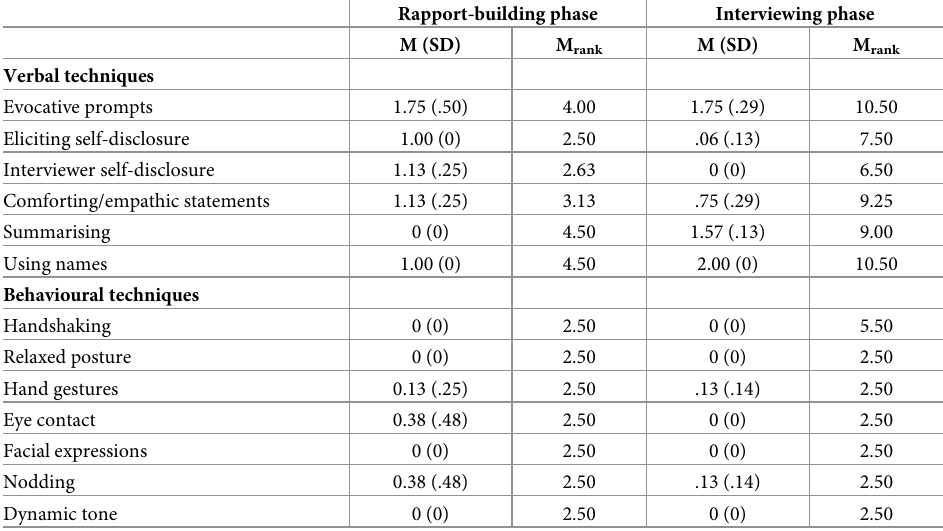
Table 2. Mean coding and Kruskal-Wallis rankings (standard deviations) for techniques in the verbal rapport condition as a function of the rapport-building and interviewing phase. Rapport-building